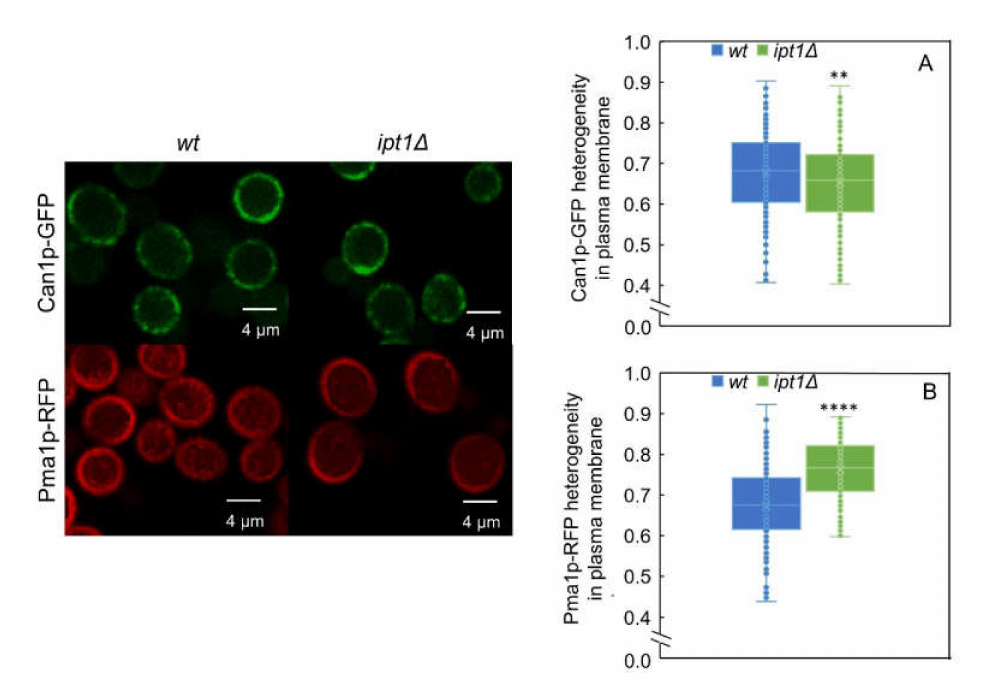
Figure 6. MCP distribution in the plasma membrane is di ff erent in wt cells and ipt1 ∆ cells. The heterogeneity of Can1p-GFP and Pma1p-mRFP distribution along the plasma membrane was determined for wt cells ( A ) and ipt1 ∆ cells ( B ) as described in the experimental procedures. The values are the median ± S.D. of at least four biological replicates with a total of at least 190 cells analyzed per replicate. **, p ≤ 0.01; ****, p ≤ 0.0001. On the left, representative confocal fluorescence images of living S. cerevisiae cells with or without deletion of IPT1 and expressing either Can1p-GFP or Pma1p-mRFP, as indicated, are